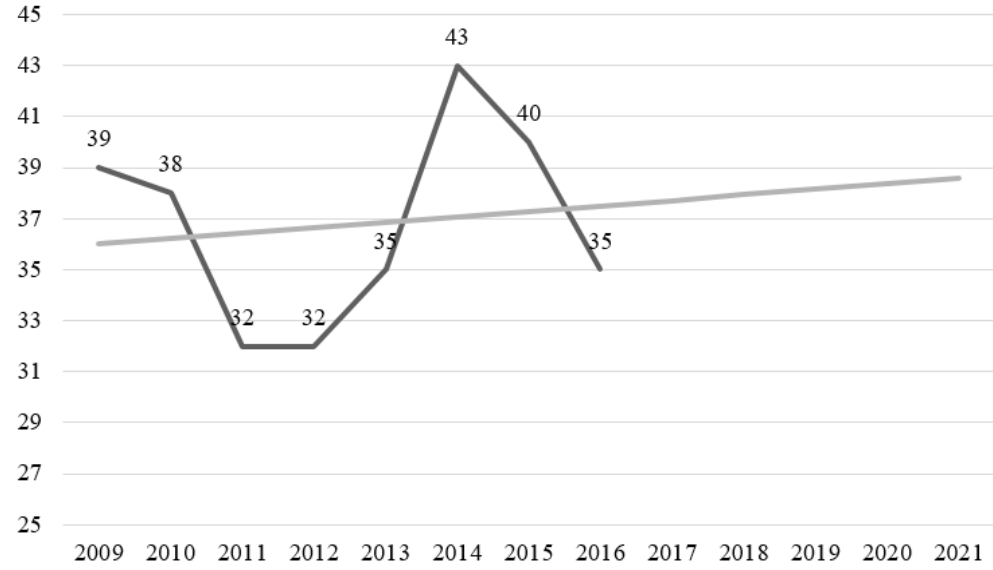
Figure 2. Forecast of the shadow economy in Ukraine,